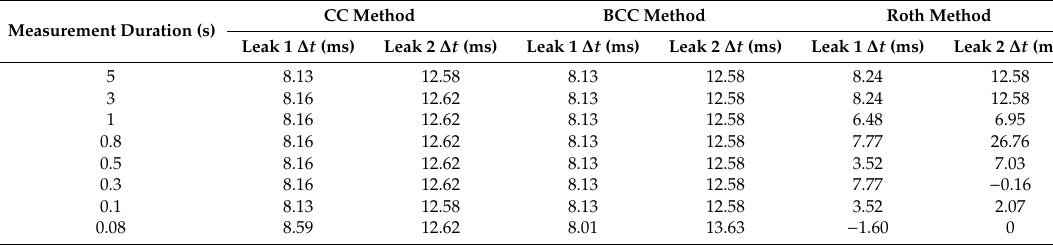
Table 9. Estimation of the time di ff erence ∆ t for several measurement durations.